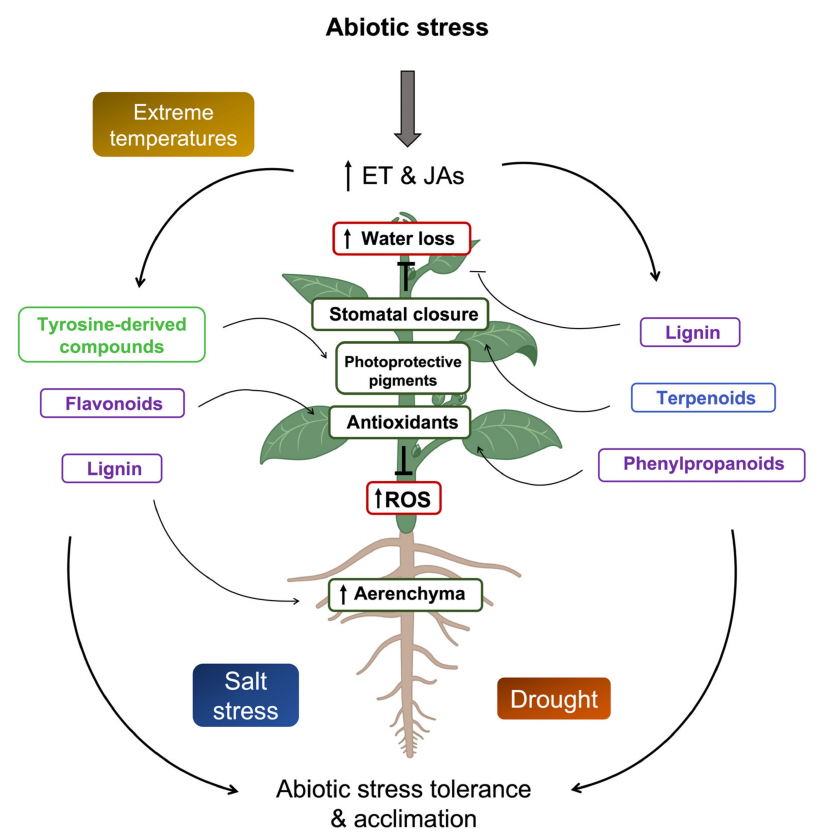
Figure 3. Schematic representation of ethylene and jasmonates effects on secondary metabolites under abiotic stress in plants. Extreme temperatures, salt stress, or drought trigger